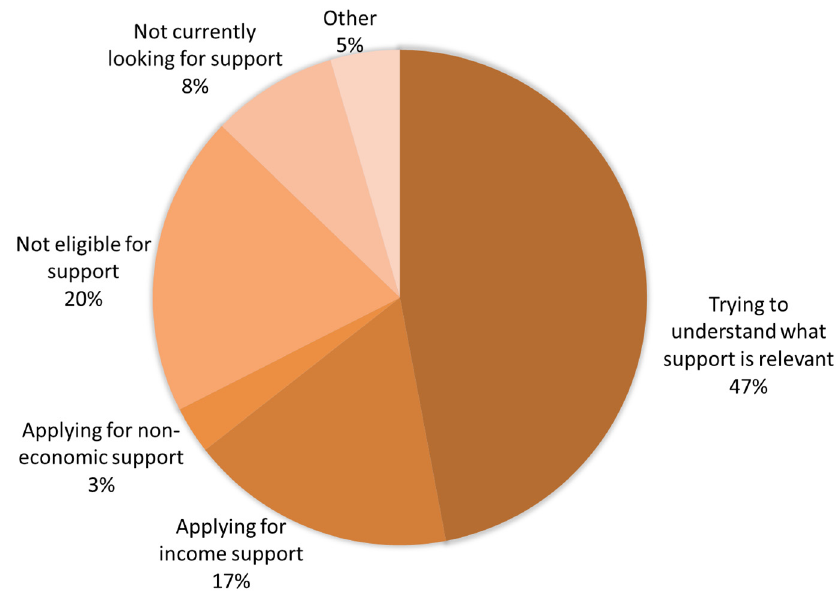
Figure 1. Study 1—visual arts workers accessing sector support measures in April 2020 (Earthen